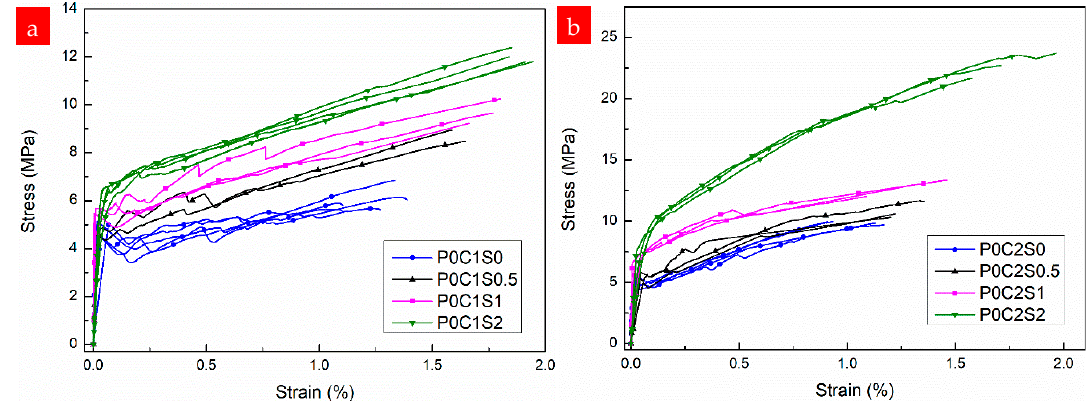
Figure 11. Stress–strain curves of the TRM specimens with varying volume fractions of short steel fibers: ( a ) one ‐ layer and ( b ) two ‐ layer textiles.